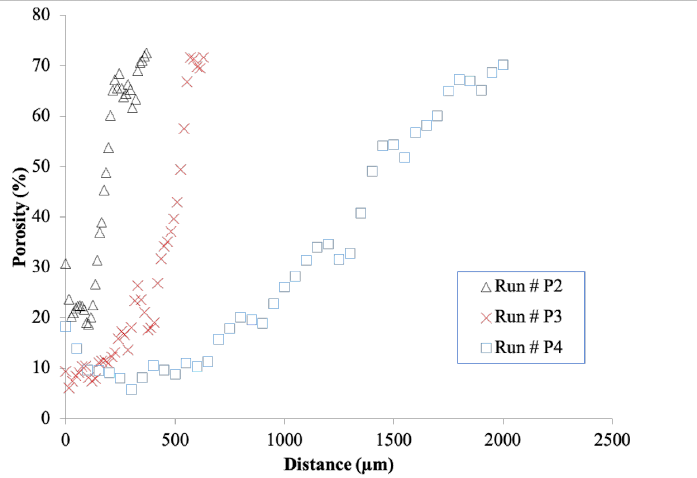
Figure 9. Porosity profiles for 3 successive infiltrations #P2, P3, and